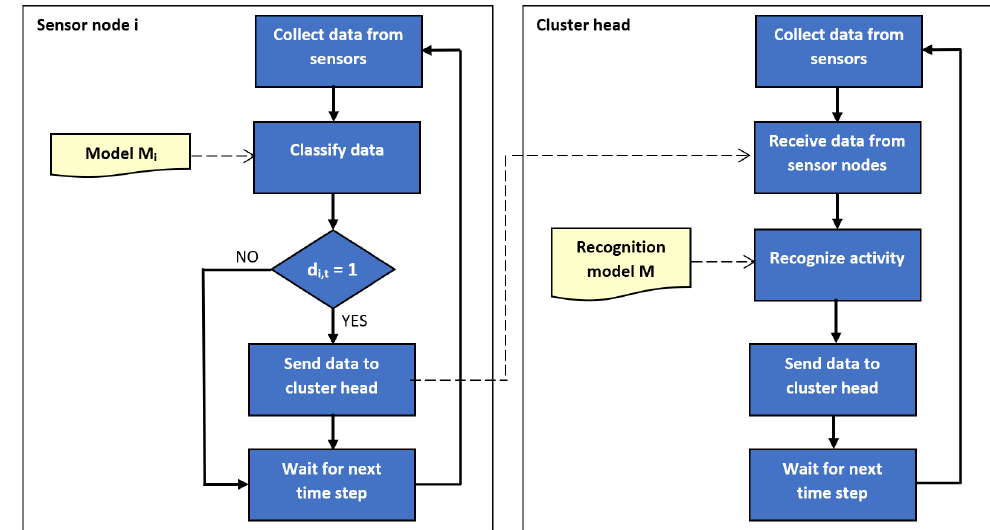
Figure 2. Block diagram of the proposed method: network operation